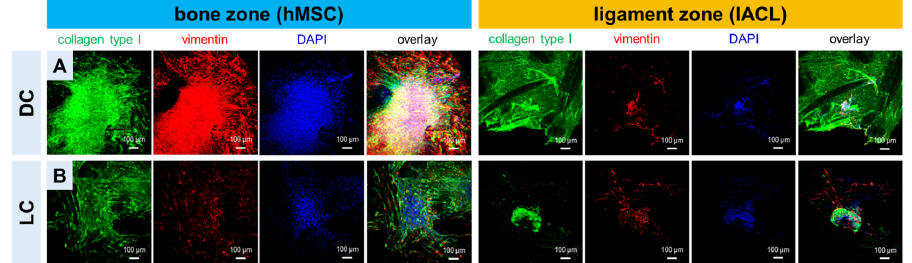
Figure 4. Extracellular matrix formation and vimentin expression after 14 days of scaffold culture. Immunocytochemical staining of collagen type I, mesenchymal marker vimentin and counterstain ‐ ing of cell nuclei (4’, 6 ‐ Diamidino ‐ 2 ‐ Phenylindole, DAPI) of human mesenchymal stem cell (hMSC) and lapine anterior cruciate ligamentocyte (lACL) spheroids, which were directly placed on the scaffold zones immediately after the 2 days of spheroid assembly ( A , DC) or with spheroids pre-cultured for 14 days ( B , long-time: LC) before being seeded on the scaffold bone or ligament zones, shown after 14 days of scaffold cultivation. Scale bars of 100 µ